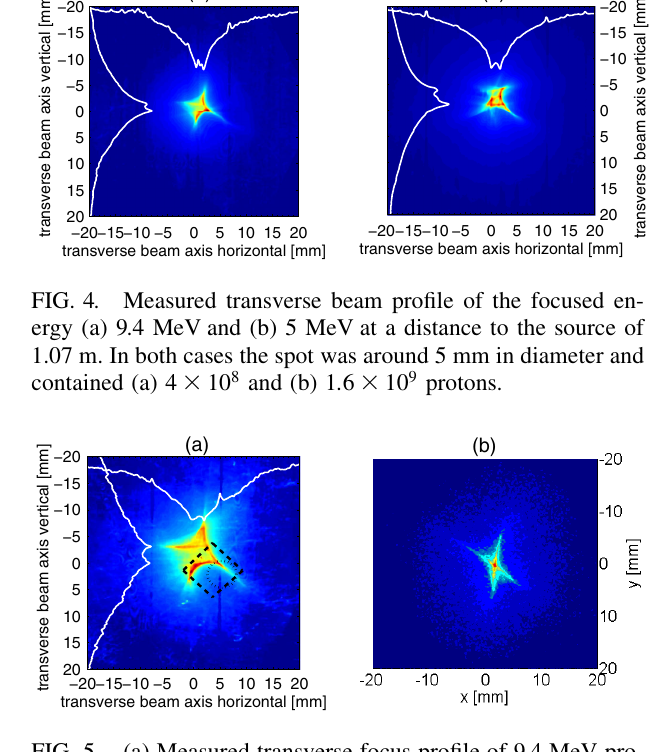
FIG. 5. (a) Measured transverse focus profile of 9.4 MeV pro- tons behind the solenoid at 2.12 m distance to source. The focus is about 10 mm in diameter and contains 5 (cid:3) 10 8 protons. (b) Simulated focal spot in the corresponding RCF layer, using a realistic wire assembly for the solenoid coil, which results in an observable astigmatism of the lens. Additionally indicated are the position of the diamond detector (dashed black square) and the optional 5 mm aperture (dashed black circle) relative to the proton